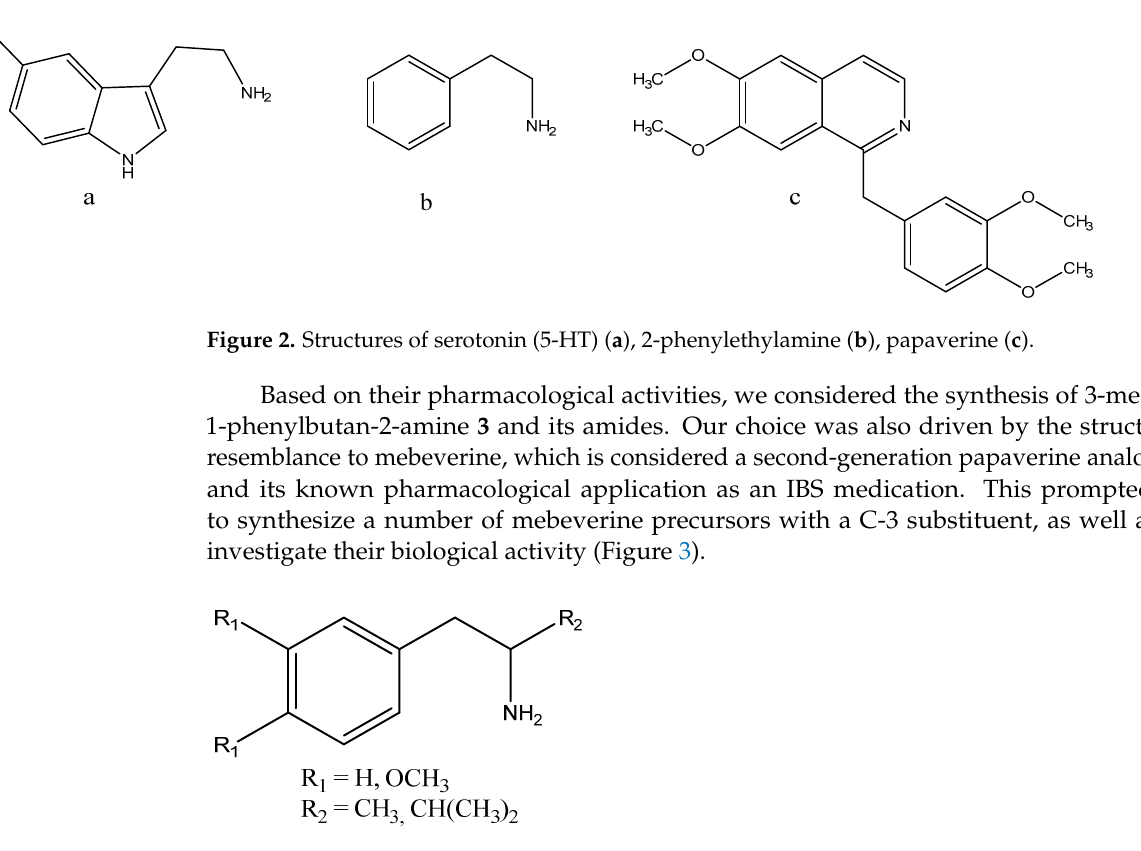
Figure 3. General structure of previously described (R 1 = OCH 3 , R 2 = CH 3 ) and newly synthesized (R 1 = H, R 2 = CH(CH 3 ) 2 ) 3-substituted 2-phenylethylamines.